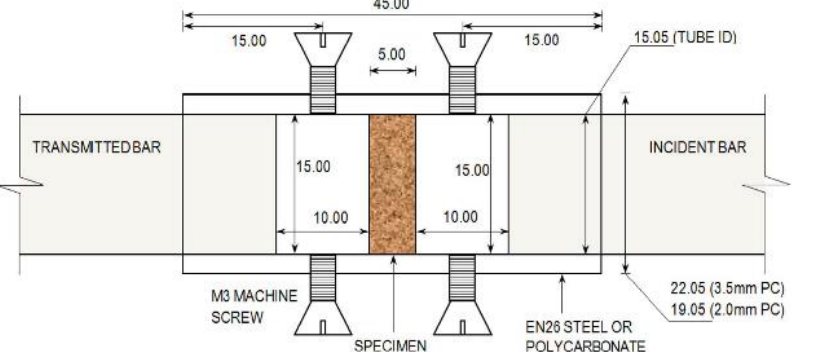
Figure 6. View of the soil sample inside the tube made of EN26 steel and 2.0/3.5 mm thick polycar- bonate with measuring bars (reprinted from Ref. [73]). Dimensions are given in millimeters.